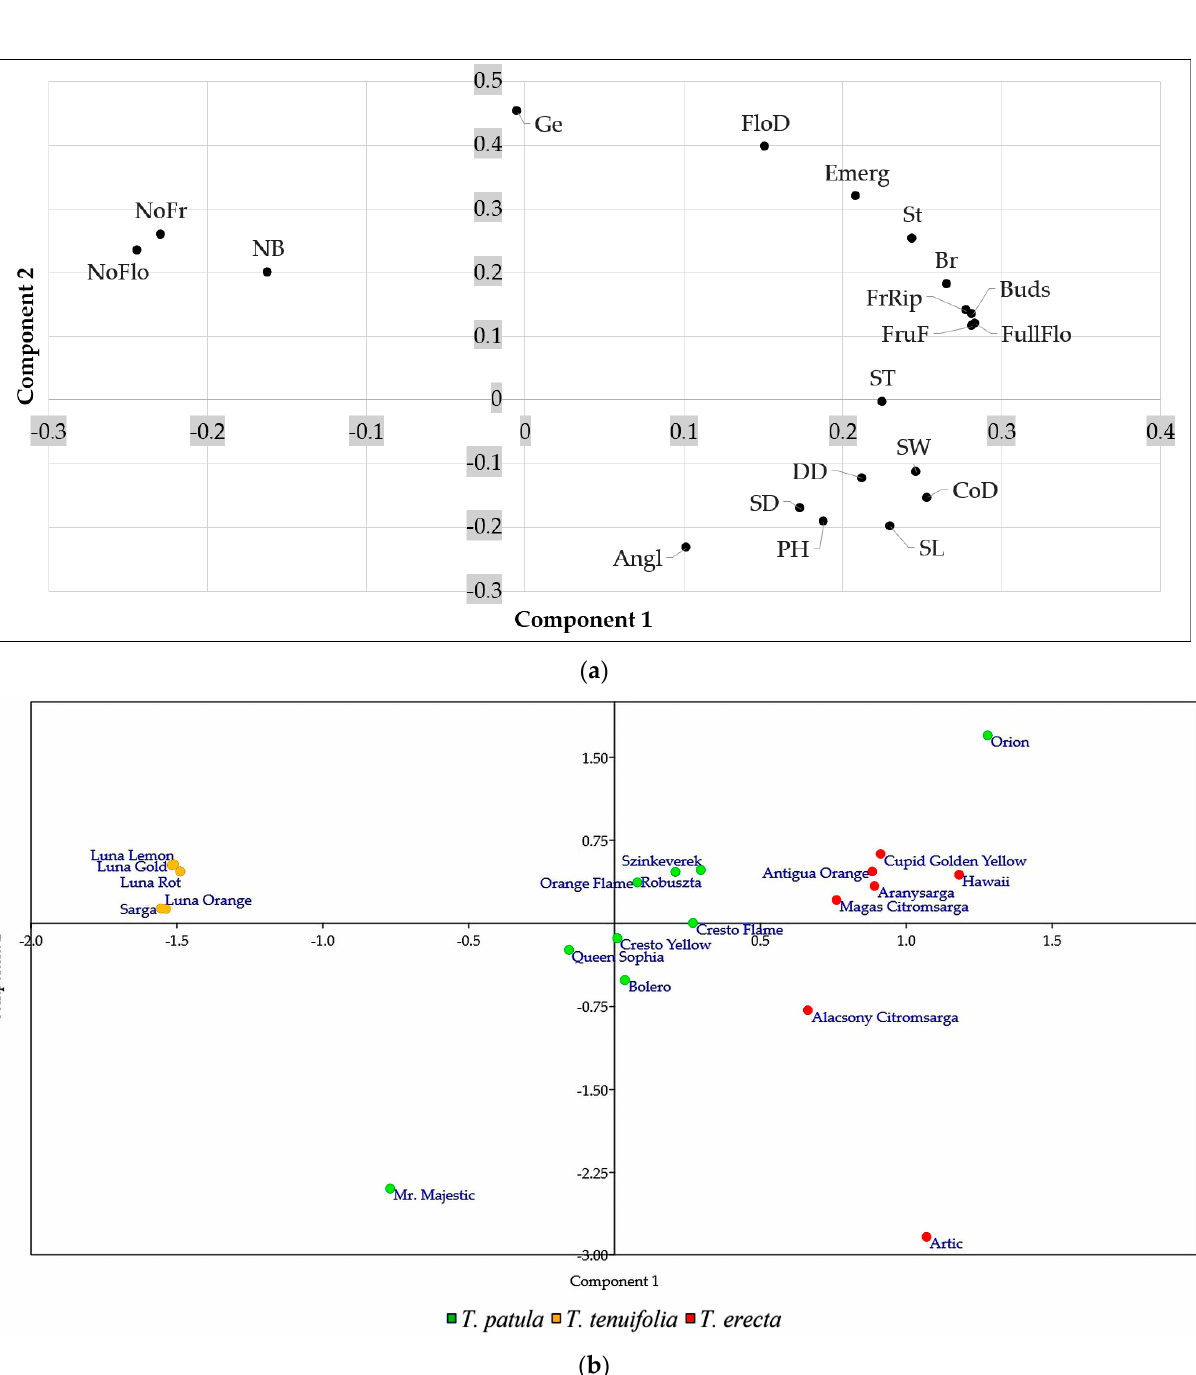
Figure 6. Principal component analysis (PCA) plot: ( a ) the multivariate variation of the traits of the 21 cultivars belonging to three Tagetes species ( T. patula , T. tenuifolia and T. erecta ); ( b ) the multivariate variation of the 20 analysed traits: SL (seed length); SW (seed width); ST (seed thickness); Ge (germination); PH (plant height); SD (stem diameter); NB (no. branches/stem); Angl (angle of branch insertion); NoFlo (no. of flowers); CoD (corolla diameter); DD (disc diameter); NoFr (no. of fruits); Emerg (emergence); St (stem formation); Br (branching); Buds (budding); FullFlo (full flowering); FloD (flowering duration); FruF (fruit formation); FrRip (fruit